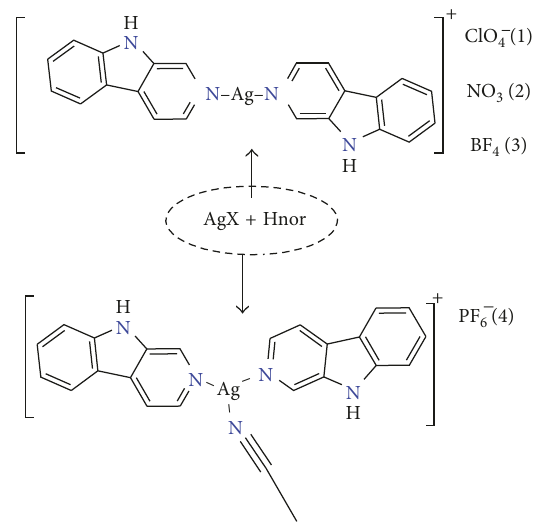
Figure 1: The structures of the ligand 9H-pyrido[3,4-b]indole (Hnor) and the four used Ag(I)